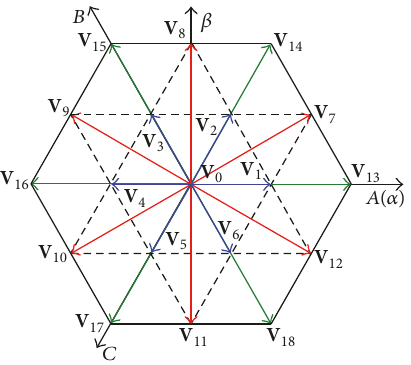
Figure 2: Space voltage vector diagram of three- level